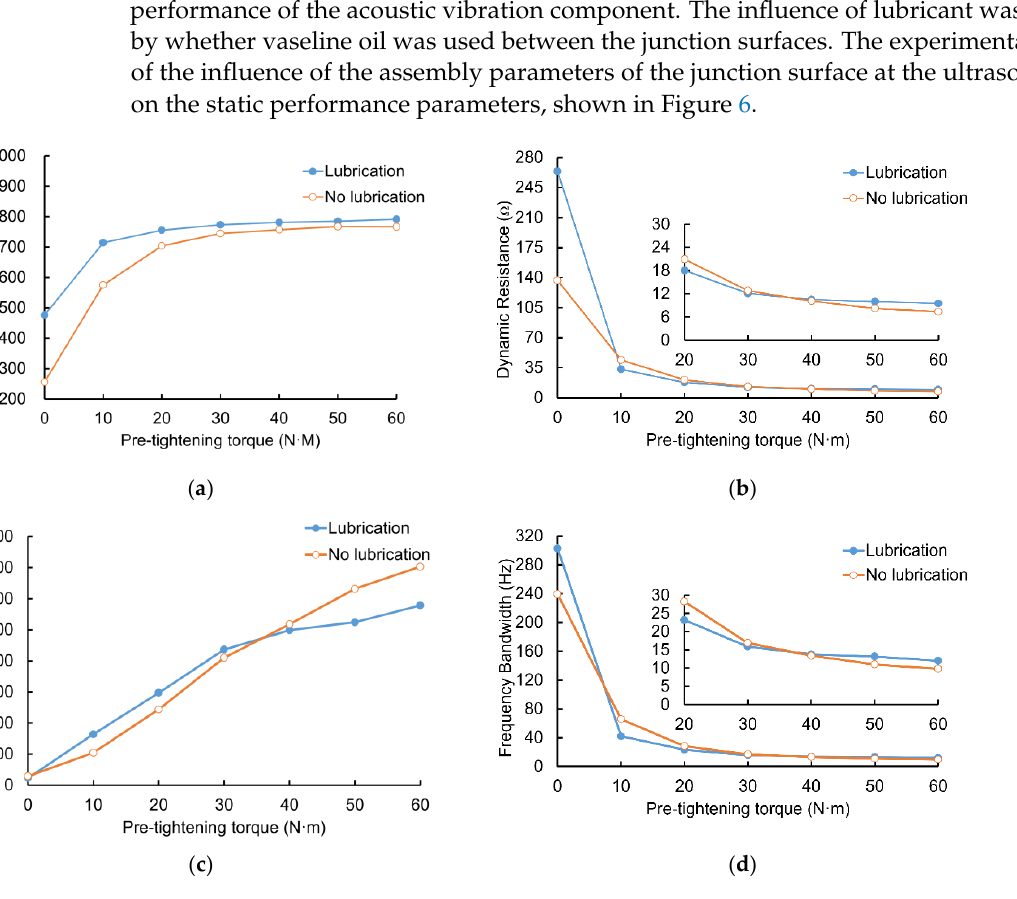
Figure 6. Influence of assembly parameters of junction surface at ultrasonic horn on static performance parameters. ( a ). Influence of pre-tightening torque of ultrasonic horn junction surface on resonance frequency. ( b ). Influence of pre-tightening torque of ultrasonic horn junction surface on dynamic resistance. ( c ). Influence of pre-tightening torque of ultrasonic horn junction surface on quality factor. ( d ). Influence of pre-tightening torque of ultrasonic horn junction surface on frequency bandwidth.